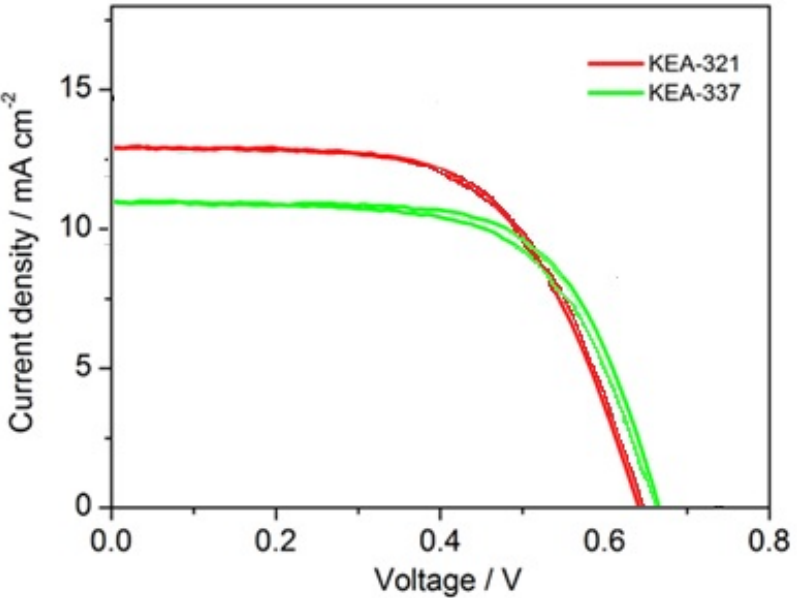
Figure 6. Current density–voltage curves of DSSCs based on the dyes of KEA series at AM1.5G, 100 mW cm − 2 .